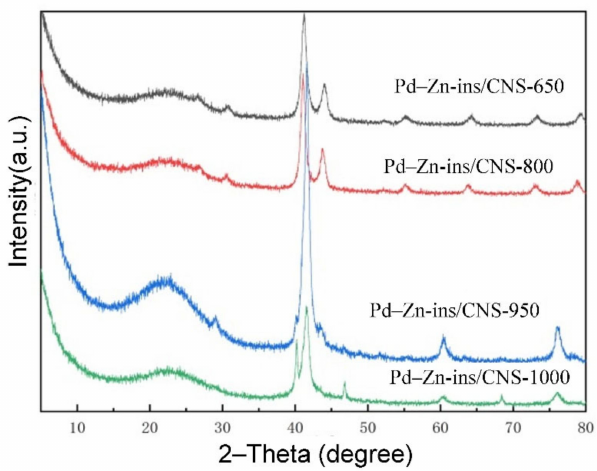
Figure 5. XRD patterns of Pd–Zn-ins/CNS-650, Pd–Zn-ins/CNS-800, Pd–Zn-ins/CNS-950, and